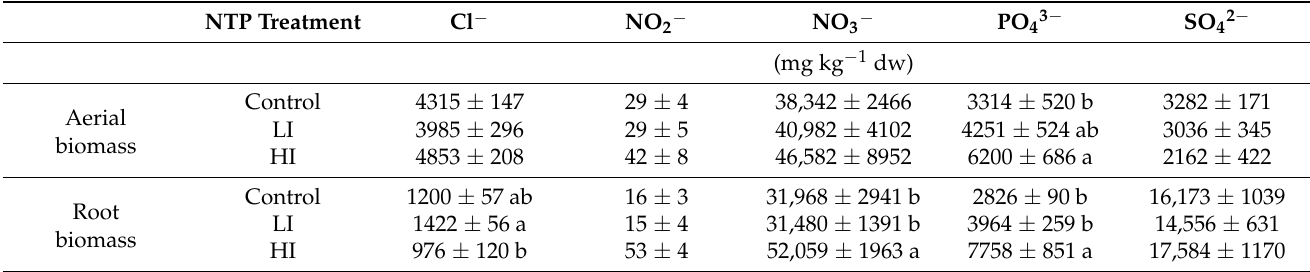
Table 5. Effect of non-thermal-plasma-activated nutrient solution on the content of anions and cations in the aerial and root biomass of lettuce.